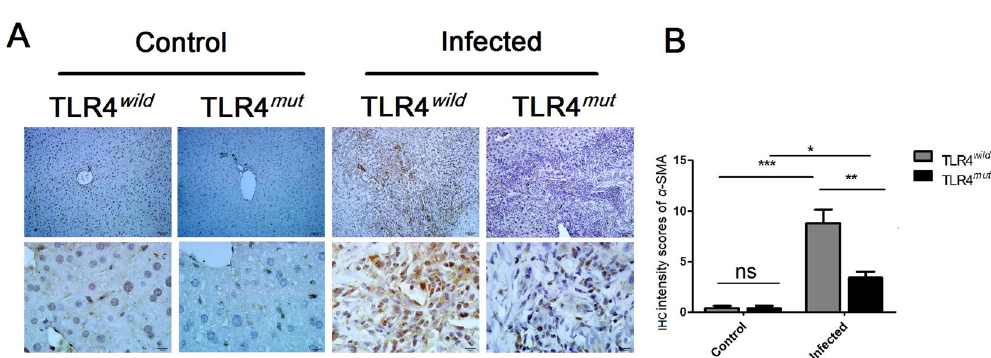
Figure 5. Impairment of TLR4 attenuates the activation of HSCs in the PABF caused by Clonorchis sinensis . Livers from TLR4 wild and mutated mice infected with or without C . sinensis were harvested, and the sections of tissue containing bile ducts were fixed by 4% formalin solution for IHC. The activation of HSCs was indicated by immunohistochemical staining of α -SMA. ( A ) Representative images of α -SMA staining on HSCs of TLR4 wild or mutated mice as indicated. Scale bars for upper panel are 50 μ m and for the nether panel are 10 μ m, respectively. ( B ) The expression of α -SMA were semi-quantitated by independent pathologists as described in Methods and Materials. The data were obtained from 3~5 mice of three-independent experiment. The values were expressed as mean ± SEM. Compared with indicated mice, * P < 0.05, ** P < 0.01, *** P <